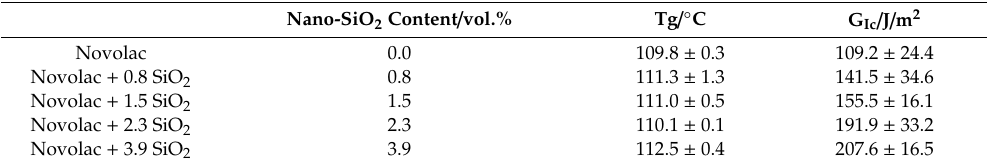
Table 3. Adjusted silica content, glass transition temperature and fracture toughness of nano-SiO 2 modified epoxy resin.